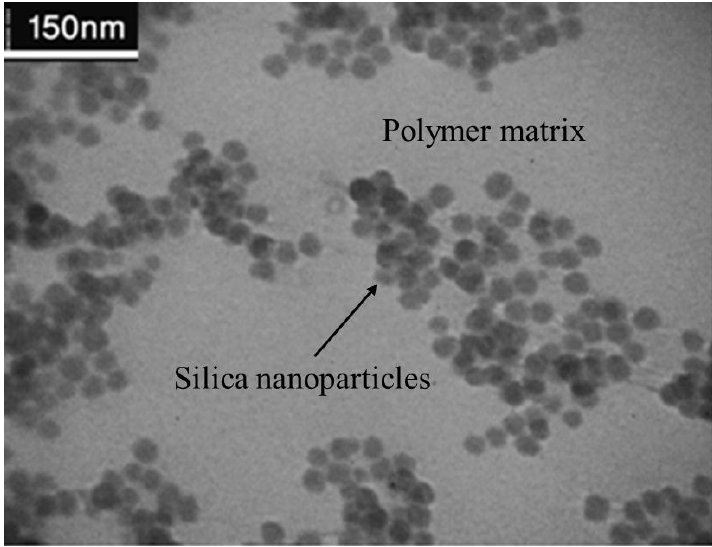
Figure 4. Transmission electron microscopy (TEM) micrographs of the composite latex particles containing silica/acrylate polymer core-shell